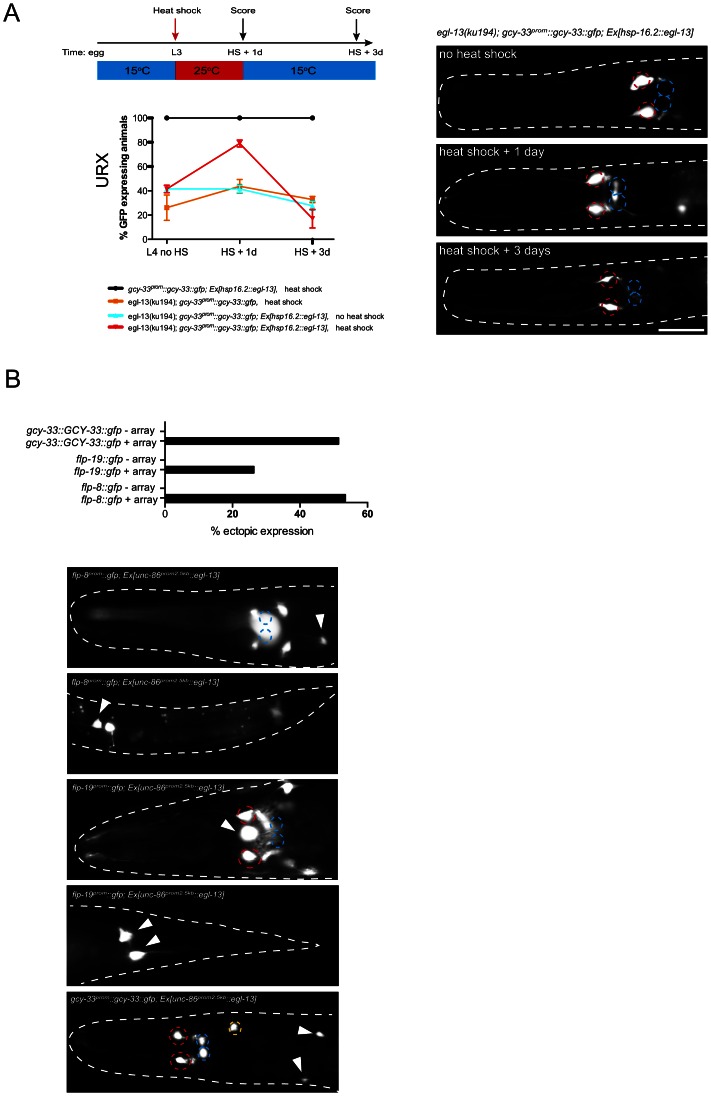

egl-13 is required and sufficient to induce O2- and CO2-sensing neuron fate.(A) egl-13 is required to maintain O2/CO2-sensing neuron fate. Induction of egl-13 expression via transient heat-shock at the L2/3 stage restores gcy-33prom::gcy-33::gfp expression in the URX neurons of egl-13(ku194) mutant animals. A schematic describing the heat-shock protocol is shown at the top left. The number of positive neurons was assessed one day after heat-shock (L2/3+1 day). No increase in the number of positive neurons was observed in egl-13(ku194); gcy-33prom::gcy-33::gfp; Ex[hsp-16.2::egl-13] animals in the absence of heat shock. A significant decrease in the number of positive neurons was observed in egl-13(ku194); gcy-33prom::gcy-33::gfp; Ex[hsp-16.2::egl-13] animals 3 days after heat shock with growth at 15°C (L4+3 days) when compared to one day after heat shock (L4+1 day). Quantification of the number of gcy-33prom::gcy-33::gfp positive neurons is shown at the indicated time points. Error bars represent the standard error of the mean (SEM). Statistical model applied is a one-way ANOVA with Newman-Keuls multiple comparison test **P<0.05, ***P<0.005. Representative fluorescent micrographs on the right indicate the continual requirement for egl-13 to maintain O2/CO2-sensing neuron fate. Neuron positions are marked with dashed circles: BAG(red), URX(blue). Two different extrachromosomal lines were analyzed for this experiment and showed similar effects (only one is shown). 53–113 animals were used per time point per genotype. See materials and methods section for heat shock protocol and for neuronal scoring criteria used. Scale bar, 20 µm. Anterior to the left. (B) egl-13 is sufficient to induce O2/CO2-sensing cell fate markers. An unc-86 promoter was used to drive broad neuronal expression of egl-13 cDNA in a wild-type background. Graph indicates the percentage of animals that exhibit ectopic expression O2/CO2-sensing cell fate marker (+ array = transgenic animals expressing unc-86prom::egl-13cDNA array; − array = transgenic siblings not expressing the array). Representative fluorescent micrographs of ectopic expression of three O2/CO2-sensing cell fate markers: flp-8prom::gfp, flp-19prom::gfp and gcy-33prom::gcy-33::gfp. Neuron positions are marked with dashed circles: BAG(red), URX(blue) and ectopic expression of each reporter is marked with arrowheads. Scale bar, 20 µm. Anterior to the left.